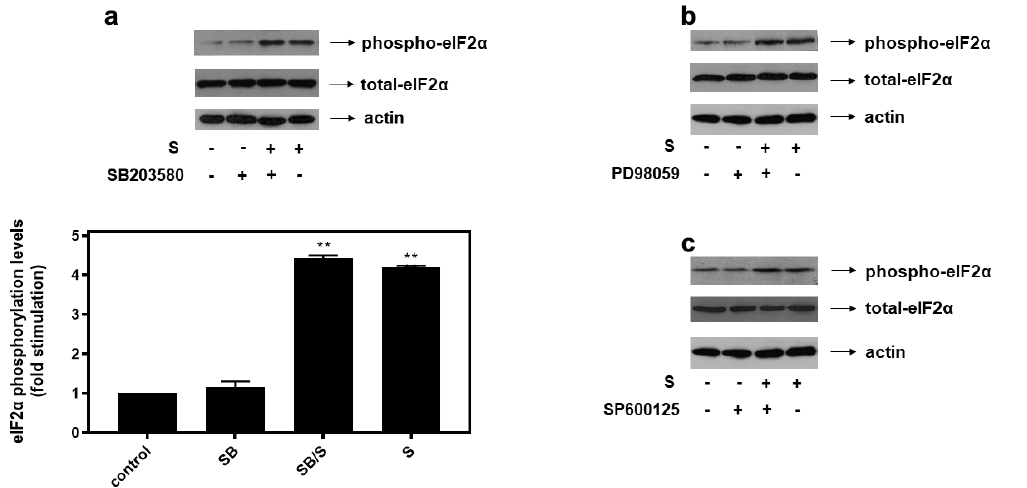
Figure 6. p38-MAPK ( a ), ERK1/2 ( b ) and JNK1/2 ( c ) are not involved in hyperosmotic-stress-induced phosphorylation of eIF2 α in H9c2 cardiac cells. H9c2 cells were left untreated (control), or treated with 0.5 M sorbitol (S), or incubated with SB203580 (SB), PD98059, SP600125, or were pre-incubated with SB203580, PD98059, SP600125 for 30 min and then exposed to 0.5 M sorbitol in the presence of SB203580 (SB/S), PD98059 and SP600125, respectively. Cell extracts (40 μ g/lane) were subjected to SDS-PAGE and immunoblotted with an antibody that detects phosphorylated eIF2 α (upper panels), total levels of eIF2 α (middle panels) as well as total levels of actin (bottom panels). Western blots are representative of at least three independent experiments with overlapping results. Immunoreactive bands were quantified by laser scanning densitometry and plotted (respective graph). Results are means ± SEM for at least three independent experiments. ** p < 0.01 compared to control values. and oxidative stress [22,23], 0.5 M sorbitol (S) was subsequently found to significantly increase dichlorofluorescein diacetate (DCFH-DA) fluorescence in H9c2 cells (3.9 ± 0.21- fold relative to control, p < 0.001), with 50 μ M tBHP (BHP) (as positive control) exerting a similar effect (4.5 ± 0.29-fold relative to control, p < 0.001) (Figure 7a). Performing oxyblot analysis, we also observed that after treatment of H9c2 cells with 0.5 M sorbitol for 1 h, levels of carbonyl groups were considerably enhanced (2.15 ± 0.05-fold relative to control, p < 0.001), indicative of the oxidative modifications conferred by hyperosmotic stress (Figure 7b). Diamide (2 mM), used as a positive control, had a similar effect (2.01 ± 0.14-fold relative to control, p < 0.001) (Figure 7b). Interestingly, inhibition of key enzymes in oxidative stress generation mitigated eIF2 α phosphorylation in H9c2 cells treated with 0.5 M sorbitol (S) for 1 h. H9c2 cells were left untreated (control) or were incubated with the inhibitors alone or with the inhibitors followed by exposure to 0.5 M sorbitol for 1 h. Thus, HOE642 (5 μ M), a specific inhibitor of Na + /H + exchanger-1 (NHE-1), as well as apocynin (10 μ M), known to inhibit NADPH oxidase (Nox) and shown to partially reverse sorbitol-induced levels of carbonyl groups in the oxyblot analysis (Figure 8a), both markedly reduced phosphorylation levels of eIF2 α by approximately 58.23 ± 0.29% and 56.96 ± 0.18%, respectively (Figure 8b, upper panel and graph, p < 0.01). Immunodetection of total eIF2 α protein levels revealed, once again, their constitutive expression (Figure 8b, middle panel). Equal protein loading was verified by immunoblotting analysis of actin levels (Figure 8b, bottom panel).